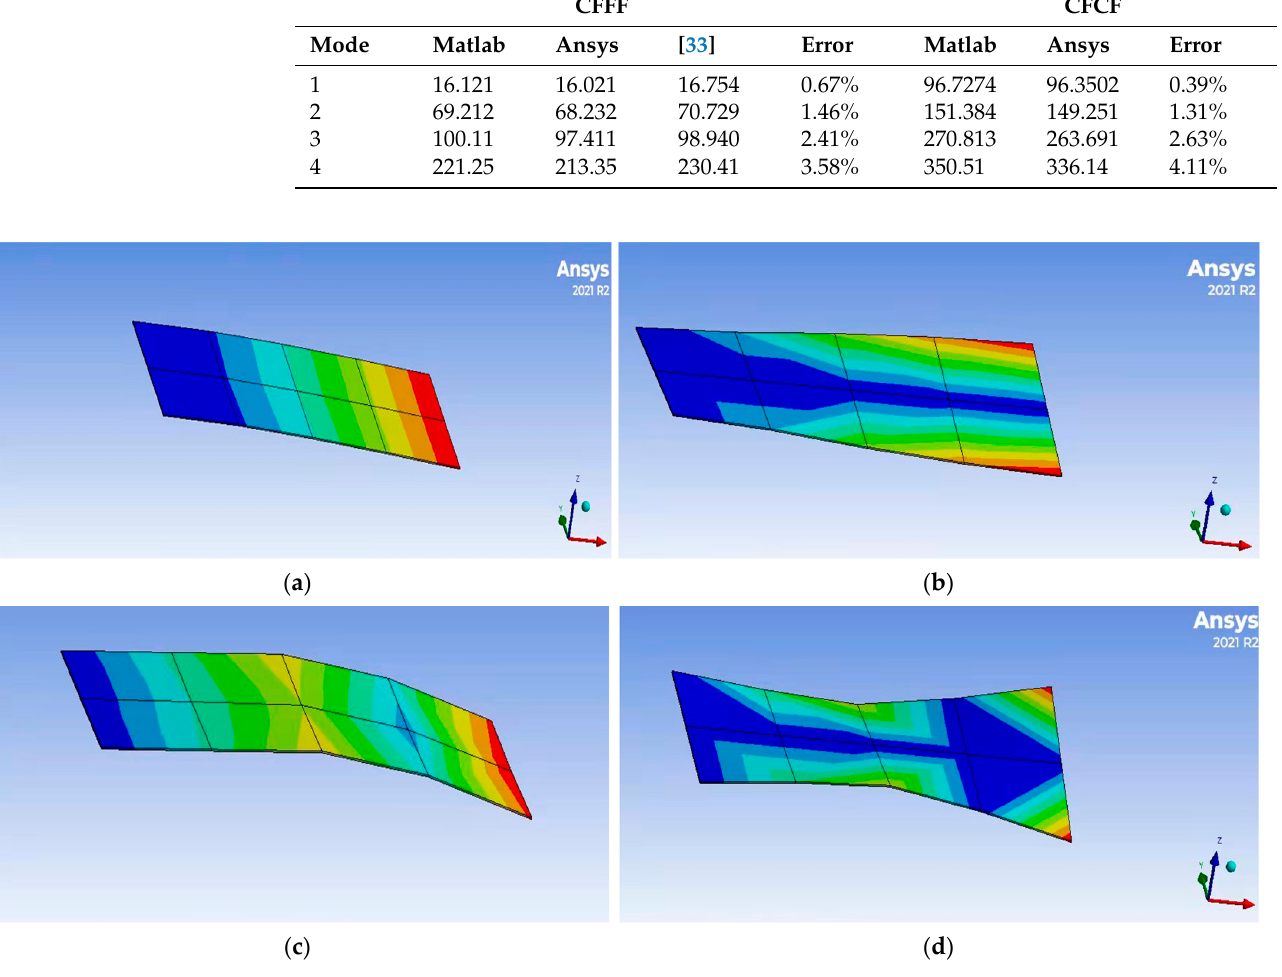
( d ) Figure 8. The first four modal shapes of cantilever plate (Matlab numerical solution). ( a ) First-order bending mode; ( b ) second-order torsional mode; ( c ) third-order bending mode; ( d ) fourth-order tor- sional mode.